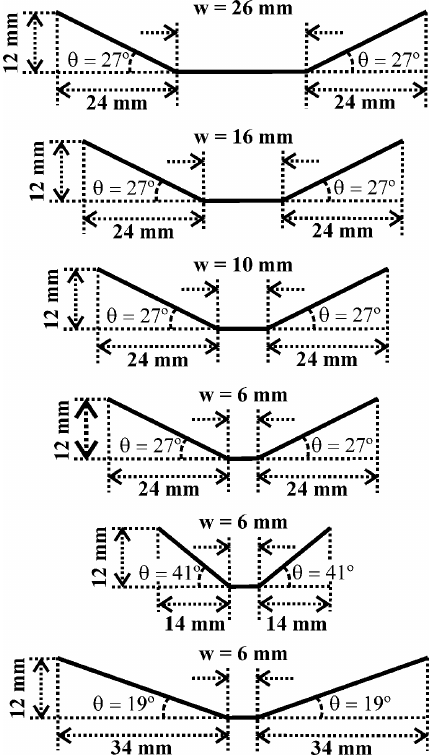
Figure 3. The different values of the channel width w and the side- wall inclination θ that are adopted in the numerical